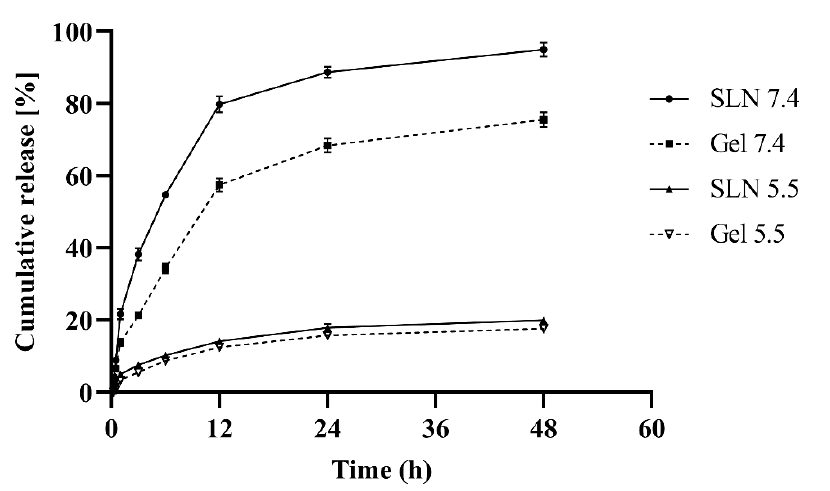
Figure 5. In vitro release profile of SLN formulation and Carbopol based hydrogel at pH 7.4 and pH 5.5.